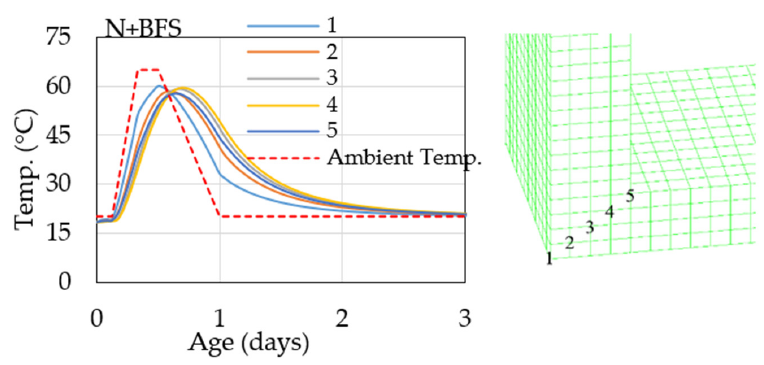
Figure 12. Simulated temperature profile at the cracking region at 25 h.